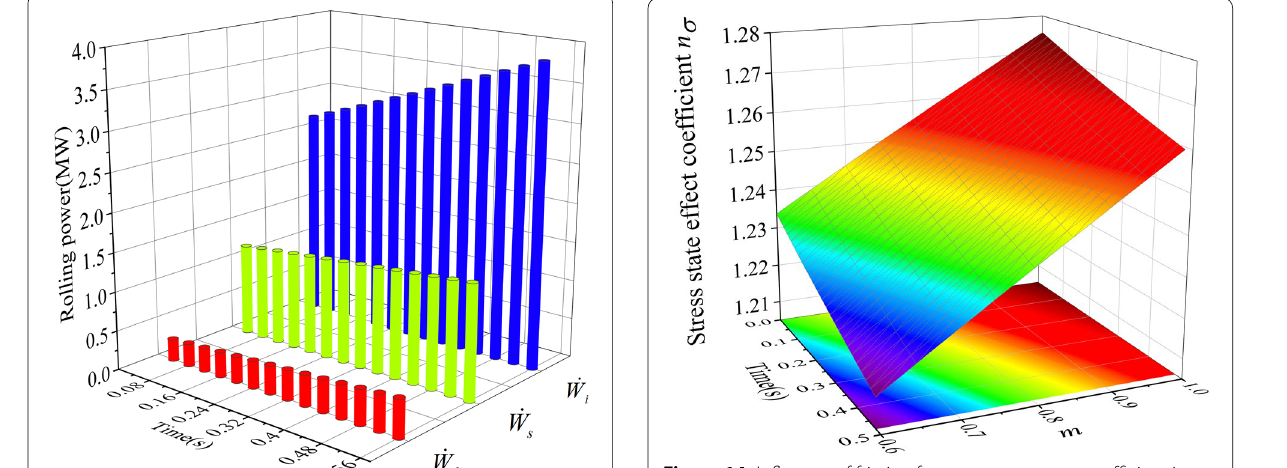
Figure 14 Influence of friction factor on stress state coefficient in downward